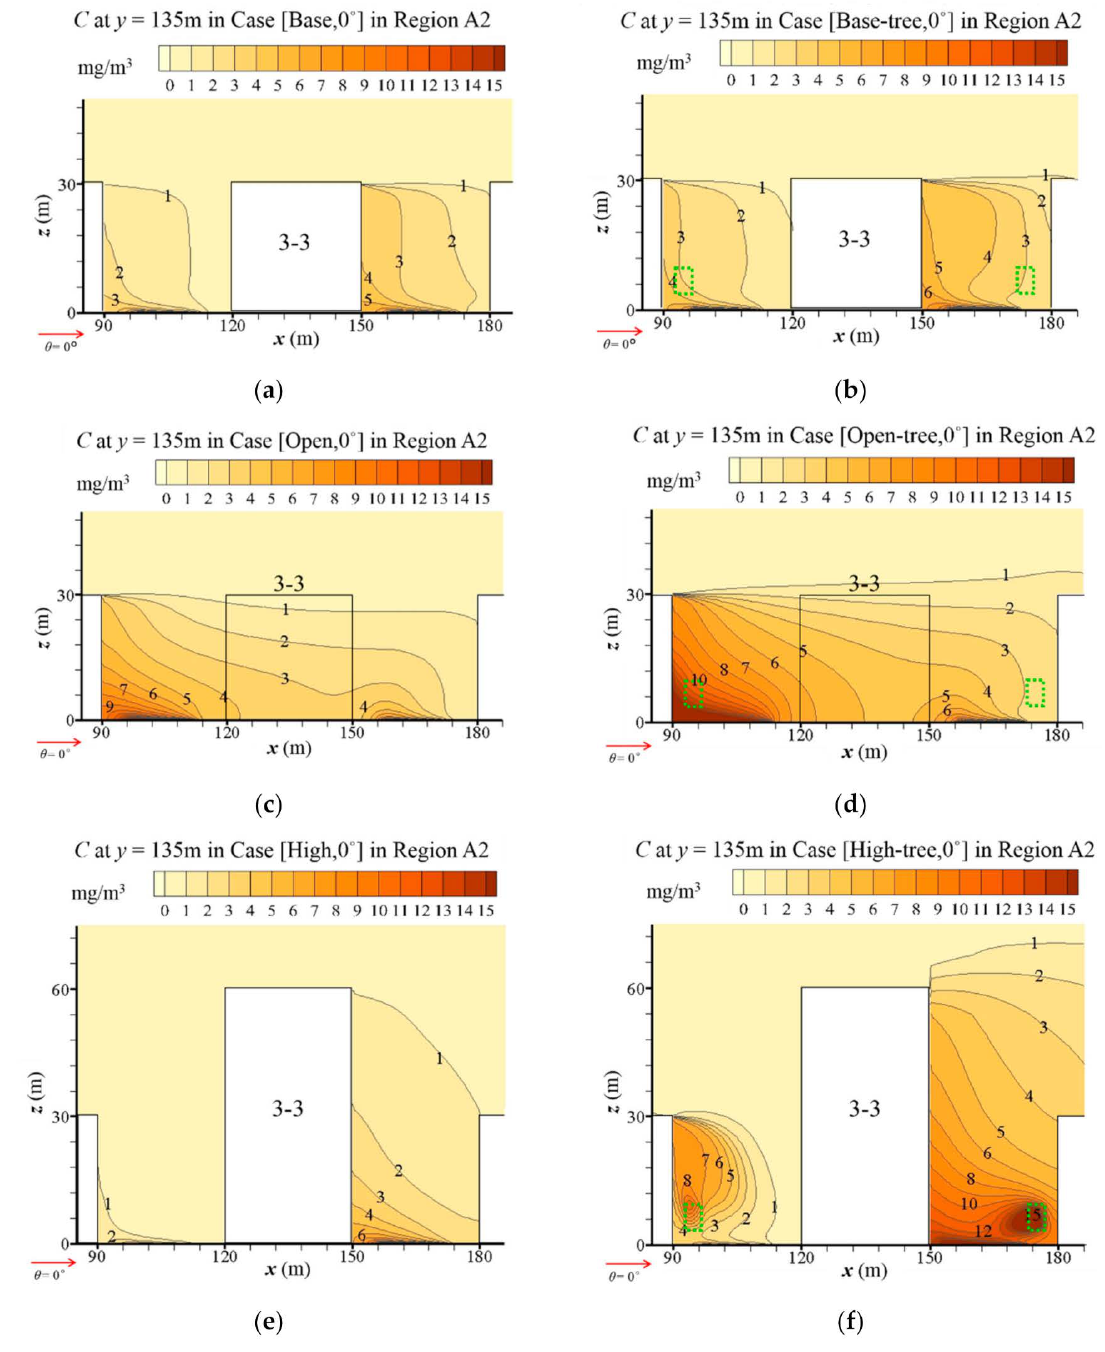
Figure 7. Vertical profile of C in Region A2 at y = 135 m: ( a ) Case [Base, 0 ◦ ], ( b ) Case [Base-tree, 0 ◦ ], ( c ) Case [Open, 0 ◦ ], ( d ) Case [Open-tree, 0 ◦ ], ( e ) Case [High, 0 ◦ ] and ( f ) Case [High-tree, 0 ◦